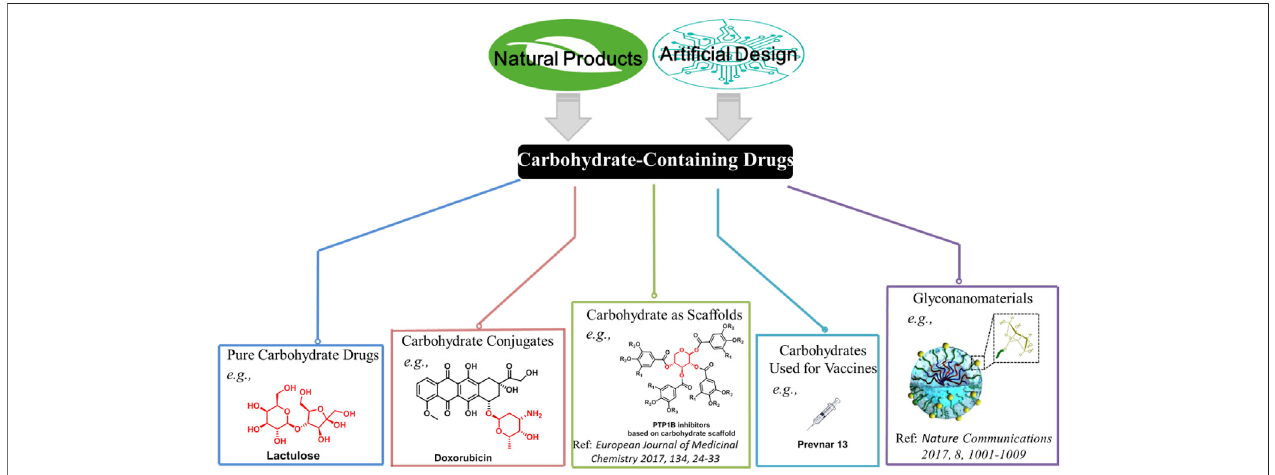
FIGURE 1 | Potential directions in the development of carbohydrate-containing drugs. Representative marketed drugs (or bioactive molecules reported) are displayed.